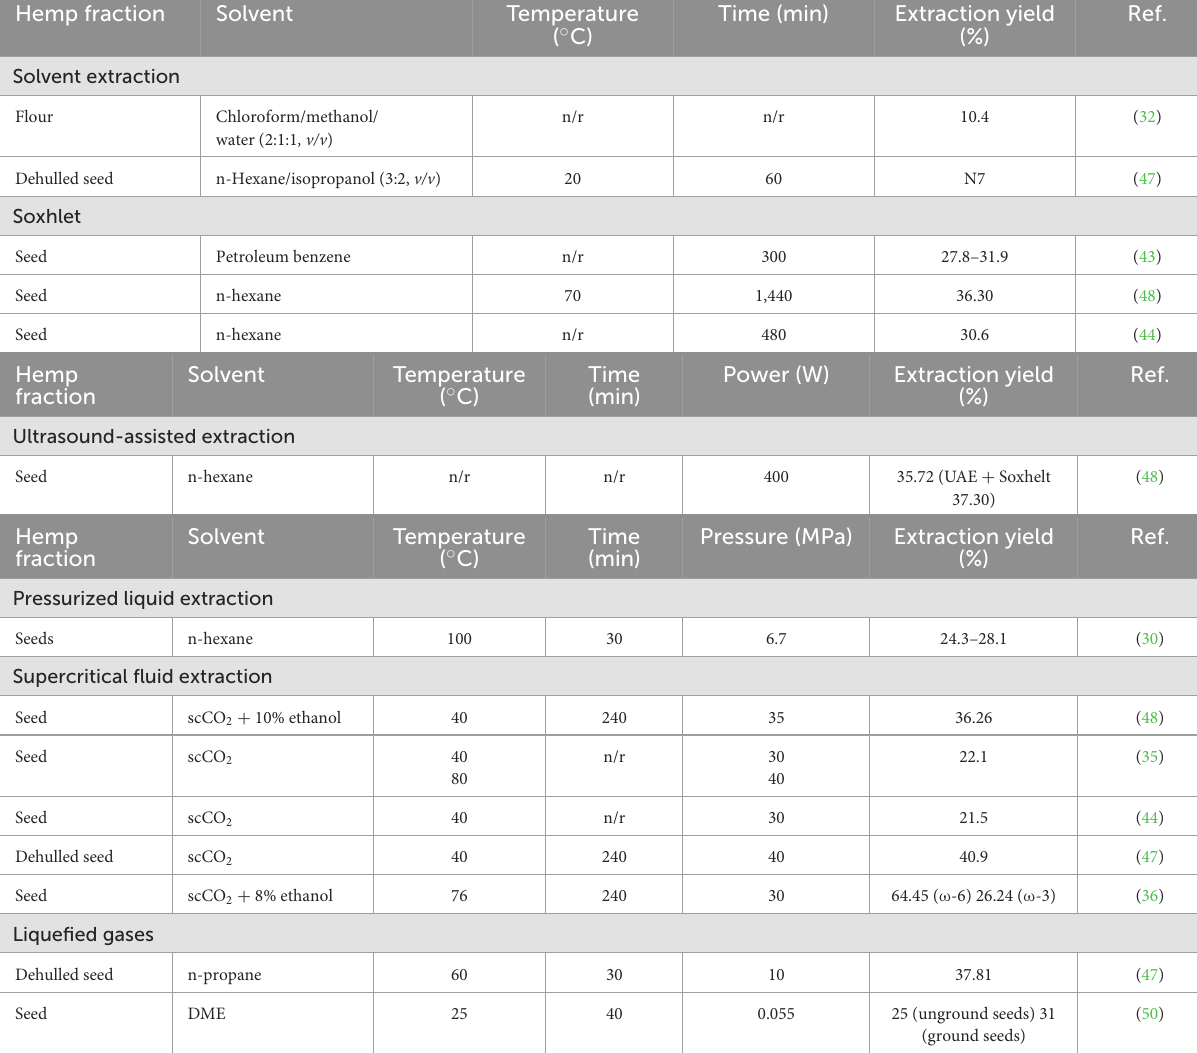
TABLE 1 Extraction techniques and methods employed for the extraction of hemp seed oil. Hemp fraction Solvent Temperature